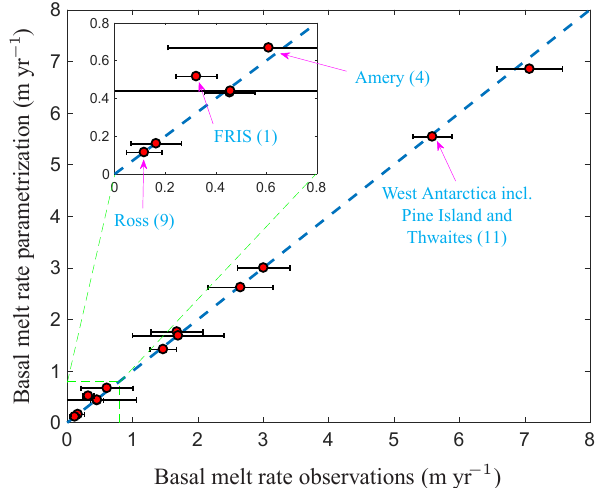
Figure 8. Area-averaged basal melt rates for each ice-shelf group in Fig. 6 obtained with the plume parametrization and the effective temperature field of Fig. 7b. The modelled melt rates are plotted against the averaged observational values given in Fig. 6. For four important shelf groups, the data points are explicitly labelled along with the corresponding group number in Fig. 6. The horizontal error bar is 1 standard deviation uncertainty in the